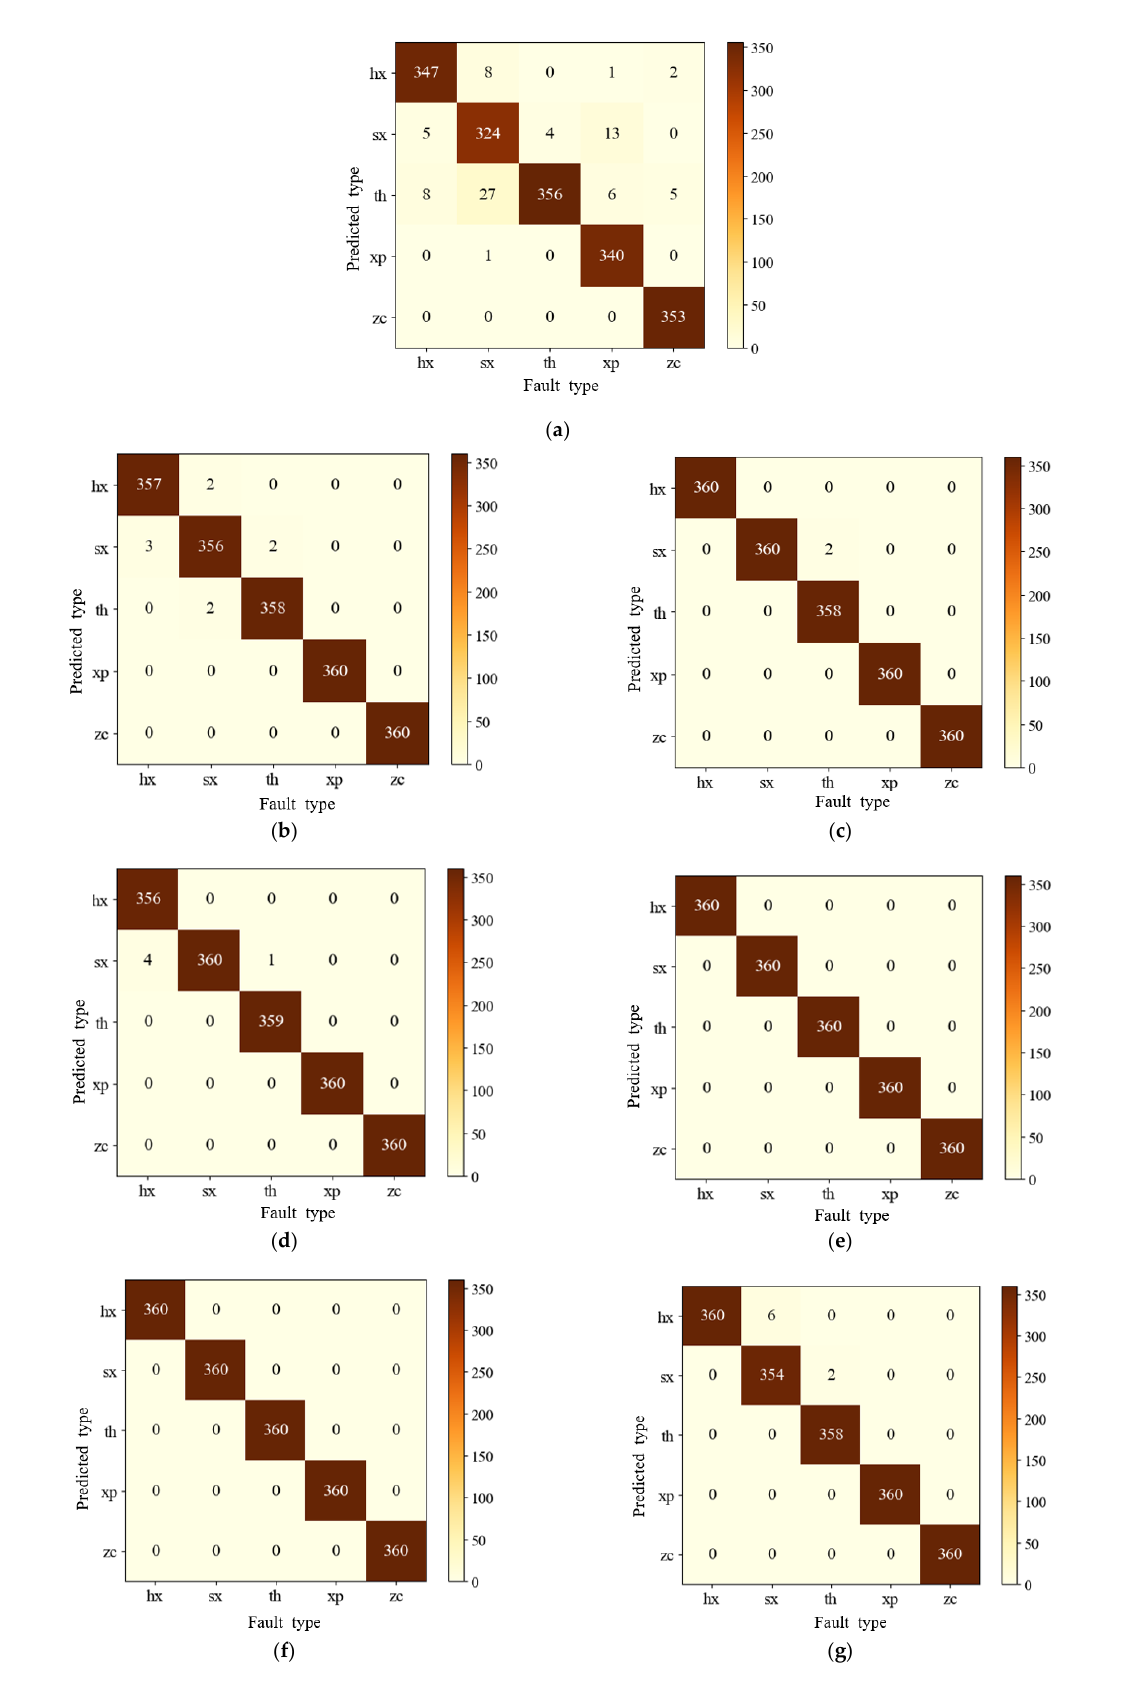
Figure 23. Confusion matrix in one trial. ( a ) I-LeNet, ( b ) I-LeNet, ( c ) 3-CNN, ( d ) 4-CNN, ( e ) VGG11, ( f ) I-AlexNet, ( g ) T-AlexNet. Table 4. Precision of I-AlexNet and T-AlexNet for different fault types.